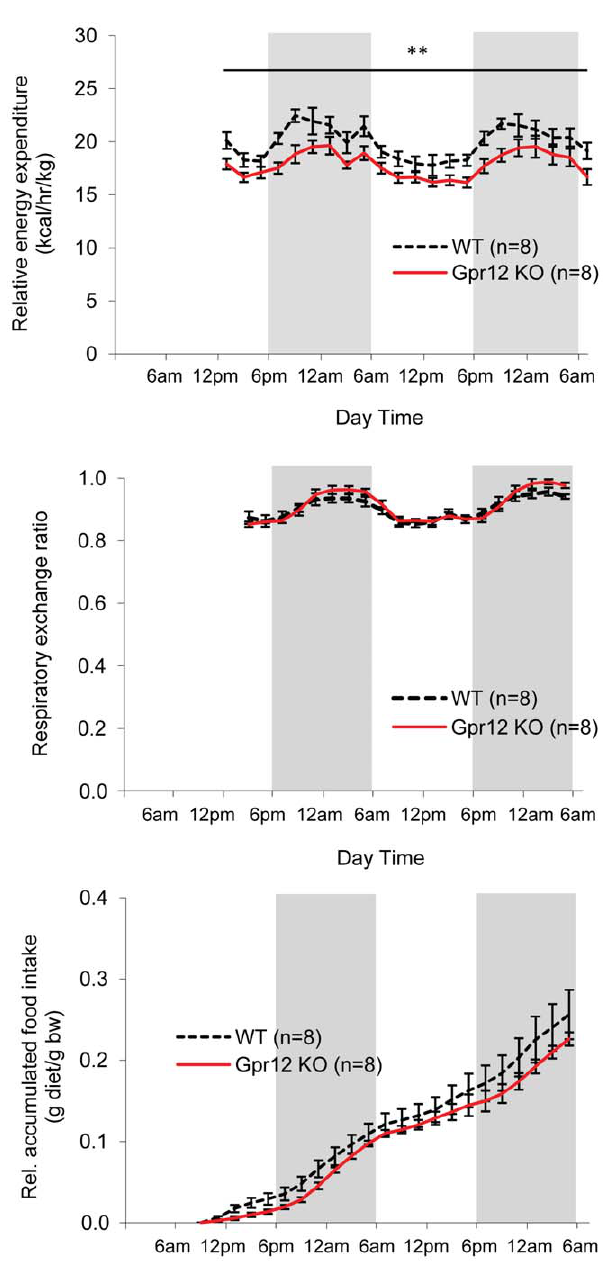
Figure 2. Energy expenditure. (A) Relative energy expenditure (EE), (B) respiratory exchange rate (RER) and (C) relative food intake (FI) of Gpr12 knockout (KO; n=8) mice (red line) and wildtype (WT; n=8) mice (dotted line). Whereas EE was significantly different between Gor12 KO and WT, RER and FI did not differ (2-way ANOVA with factors time and genotype; **p , 0.01).